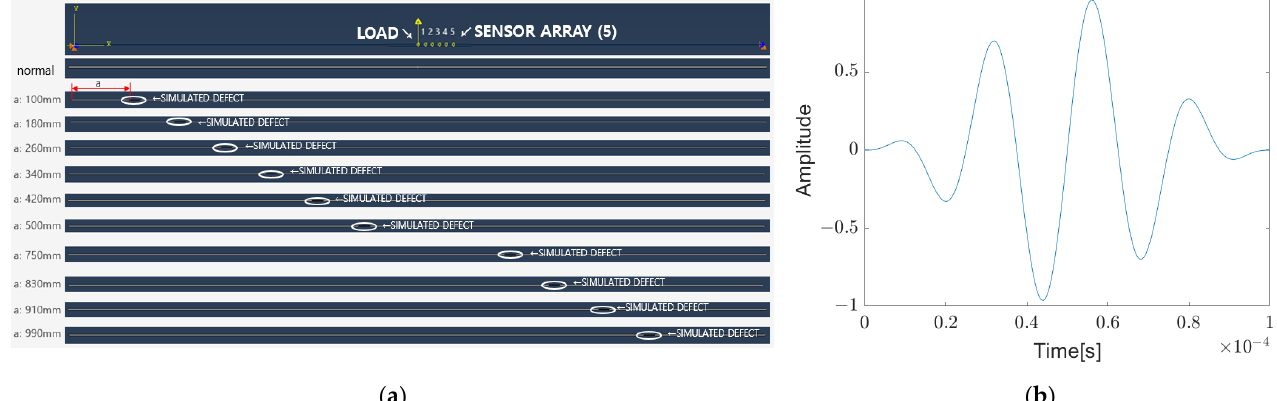
Figure 2. ( a ) Simulated 2D aluminum panels with defect; ( b ) Excitation signal with center frequency of 40 kHz.